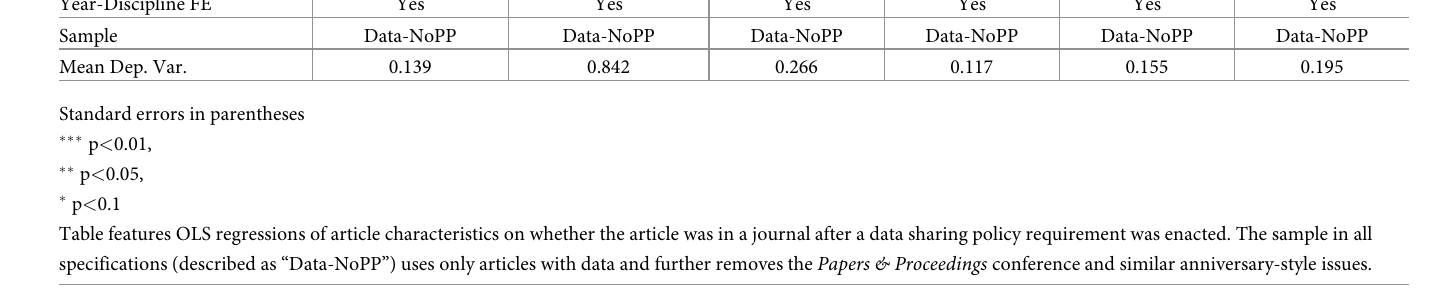
Table features OLS regressions of article characteristics on whether the article was in a journal after a data sharing policy requirement was enacted. The sample in all specifications (described as “Data-NoPP”) uses only articles with data and further removes the Papers & Proceedings conference and similar anniversary-style issues.